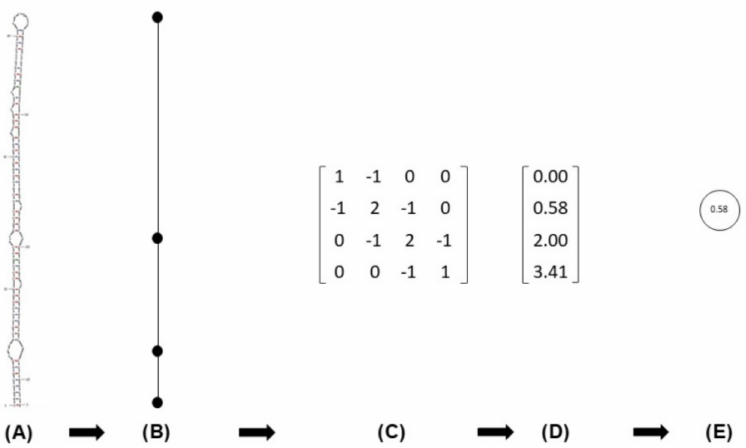
Figure 2. RNA secondary structure and coarser levels of representation. ( A ) Secondary structure of an HDV virusoid sequence taken from [47]. ( B ) Tree-graph representation of the secondary structure. ( C ) Laplacian matrix corresponding to the tree-graph representation. ( D ) Spectrum of the Laplacian matrix. ( E ) Second-smallest eigenvalue of the Laplacian